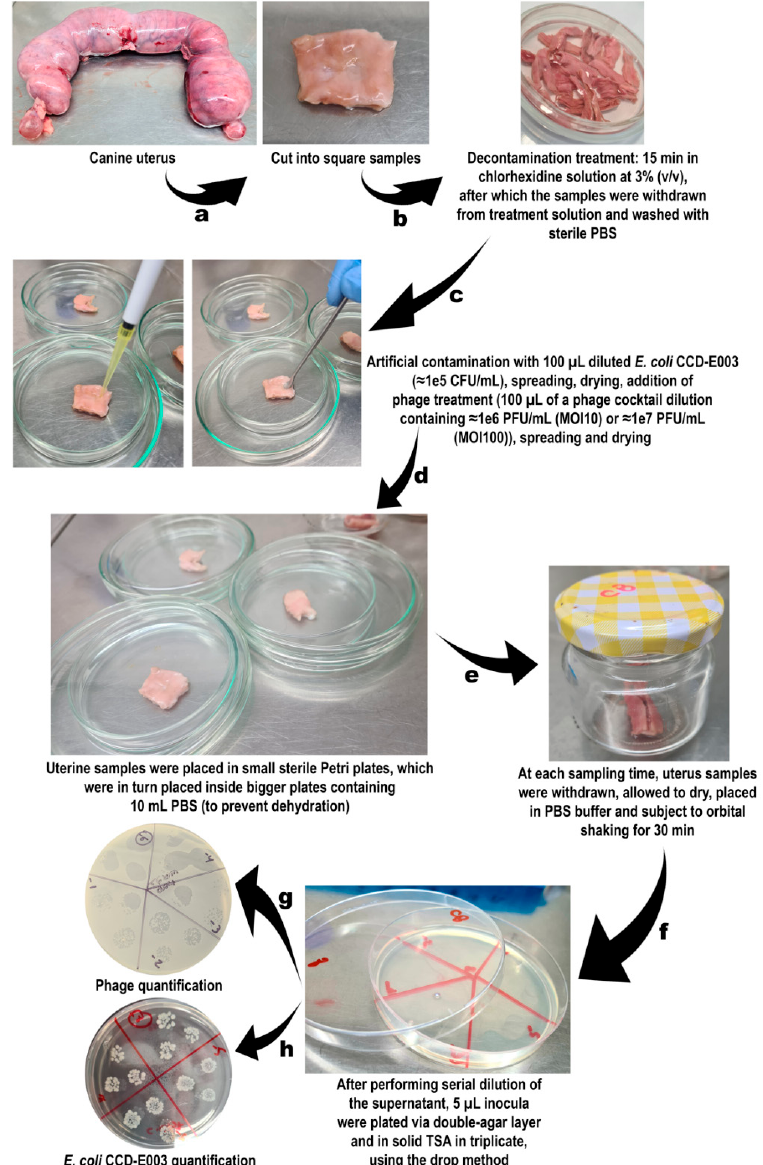
Figure 1. Simplified scheme of the ex vivo phage treatment procedure using the cocktail with phages vB_EcoM_Uniso11 and vB_EcoM_Uniso21 on artificially contaminated canine uterus. Legend: ( a ) canine uteruses were cut into square (ca. 2 cm x 2 cm) samples; ( b ) square samples of canine uterus